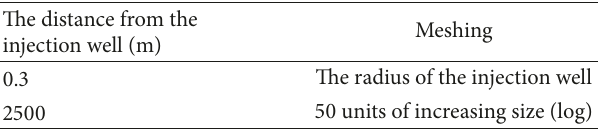
Figure 3: Solid saturation ( 𝑆 𝑠 ) and permeability ( 𝑘/𝑘 0 ) relationship for the tubes-in-series model [30]. Table 1: Radial